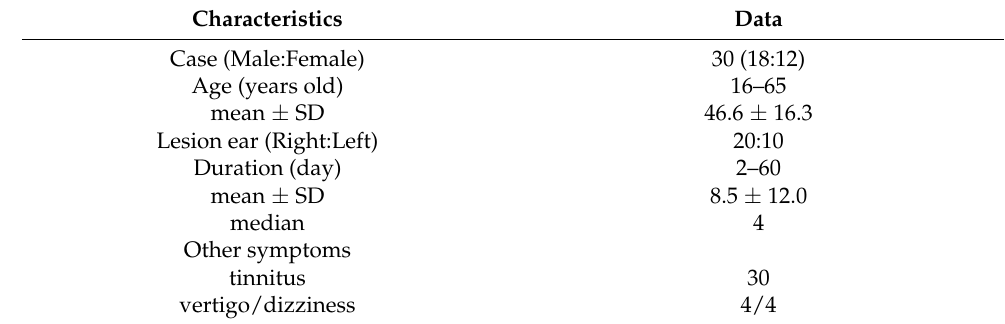
Table 1. The demographic data.